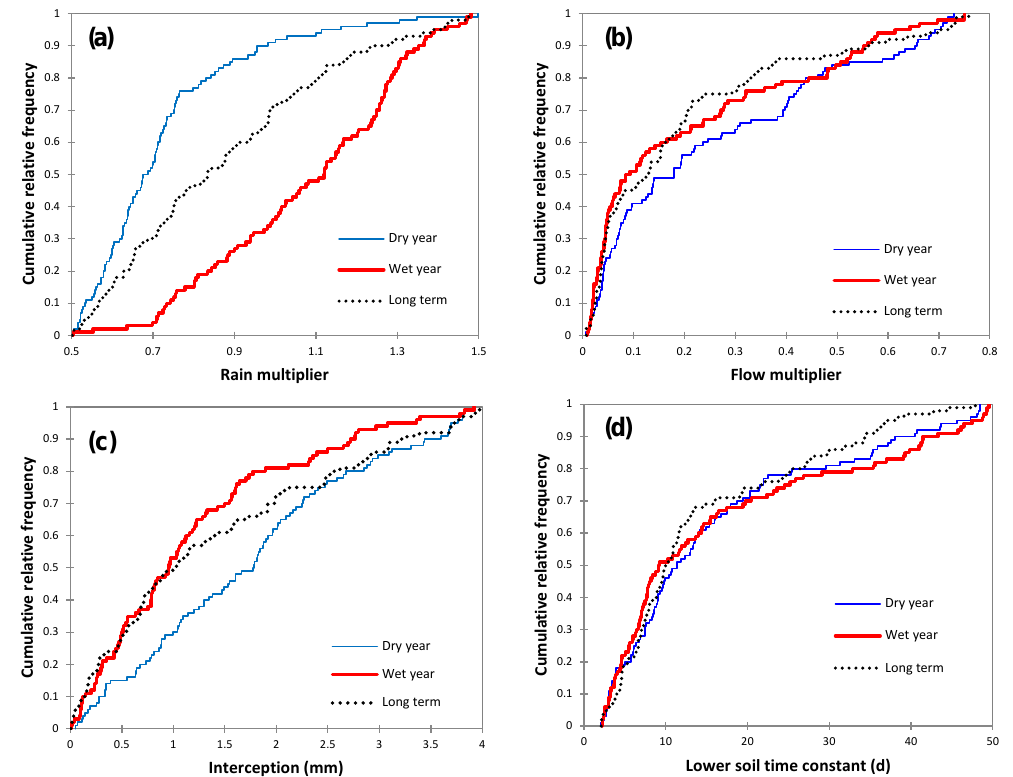
Figure 6. Cumulative distribution function (CDF) of behavioural parameters (top 100 iterations from the Monte Carlo runs) in wet and dry years vs. the long-term record. (a) is the rain multiplier, (b) is the flow multiplier, (c) is the interception and (d) is the lower soil time constant in the lower soil box. A rectangular distribution (straight line plot) defines parameter behaviours that were not sensitive (not left- or right-skewed).